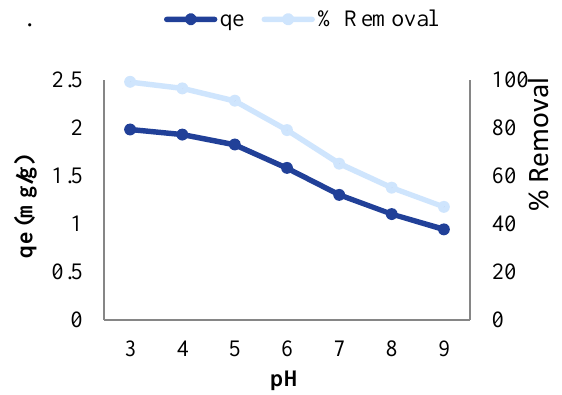
Figure 3. Effect of pH on Cr (VI) removal efficiency and adsorption capacity (C0 = 10 mg/l, adsorbent dose = 5 g/l, contact time = 75 minutes, and temperature = 30 °C) Effect of biomass